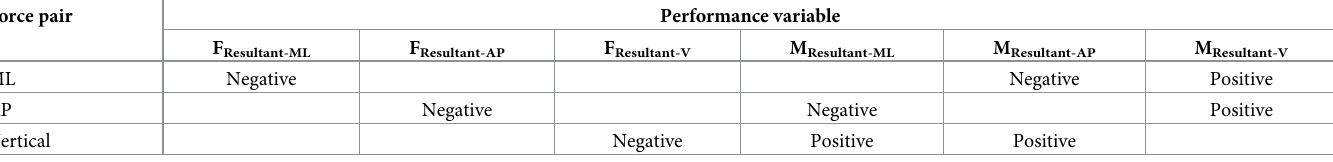
Table 4. Directions of covariations in the force pairs required to stabilize each performance